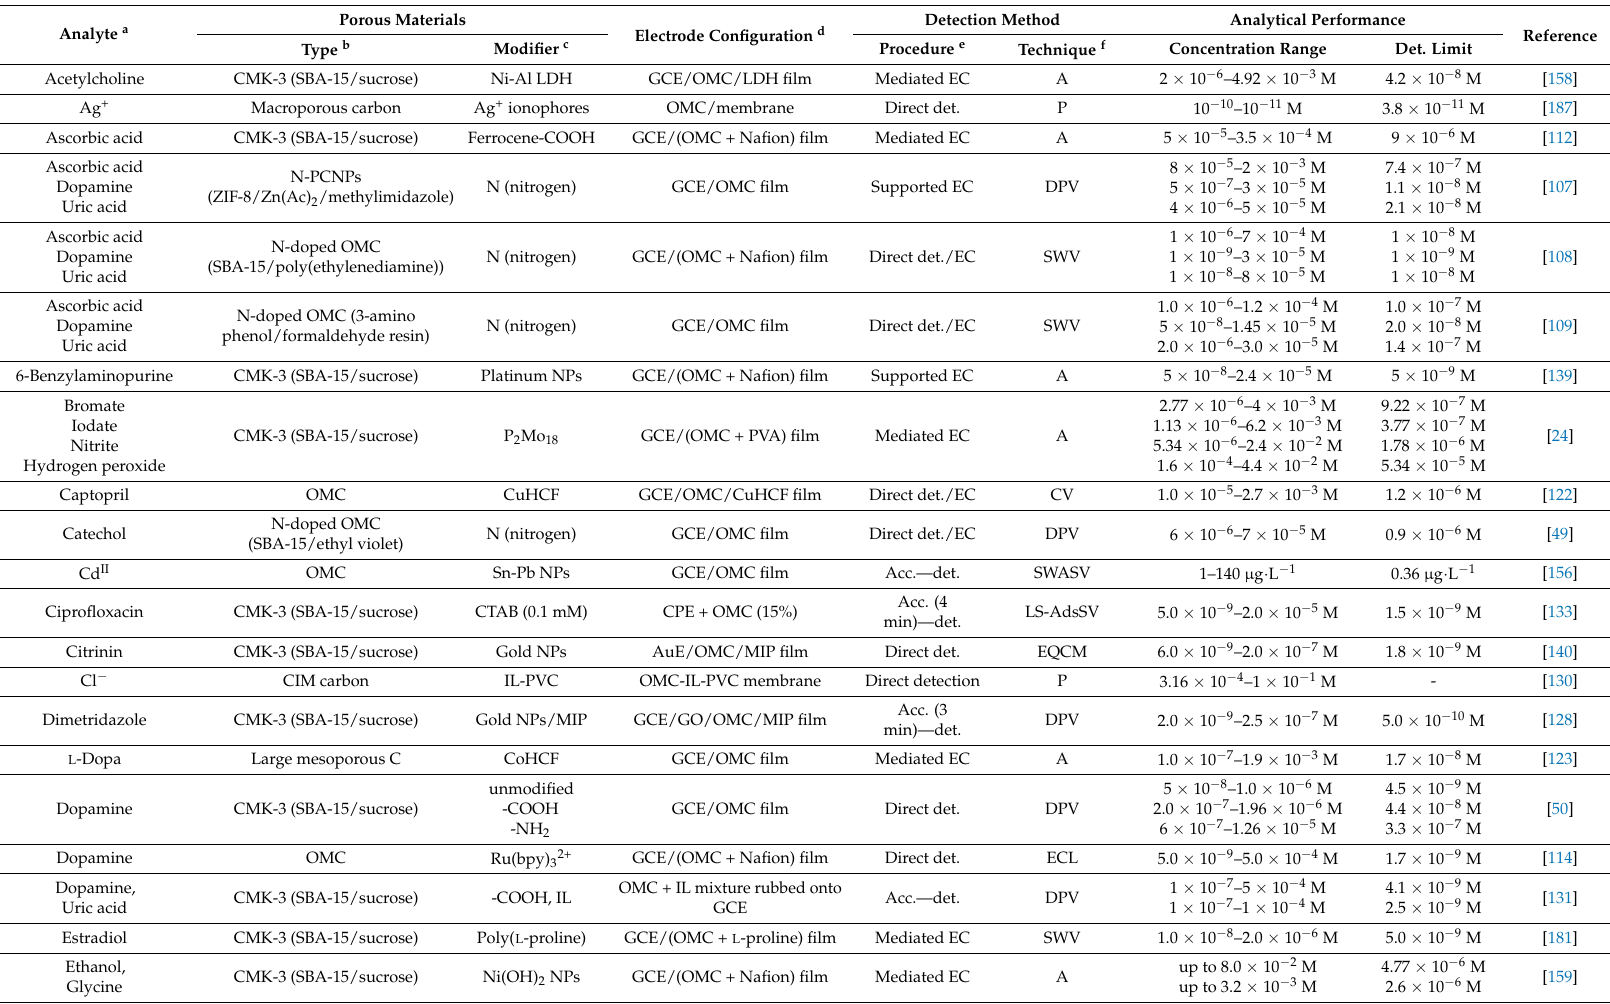
Table 2. Electrochemical sensors based on electrodes prepared from functionalized templated ordered porous carbon materials. Analyte